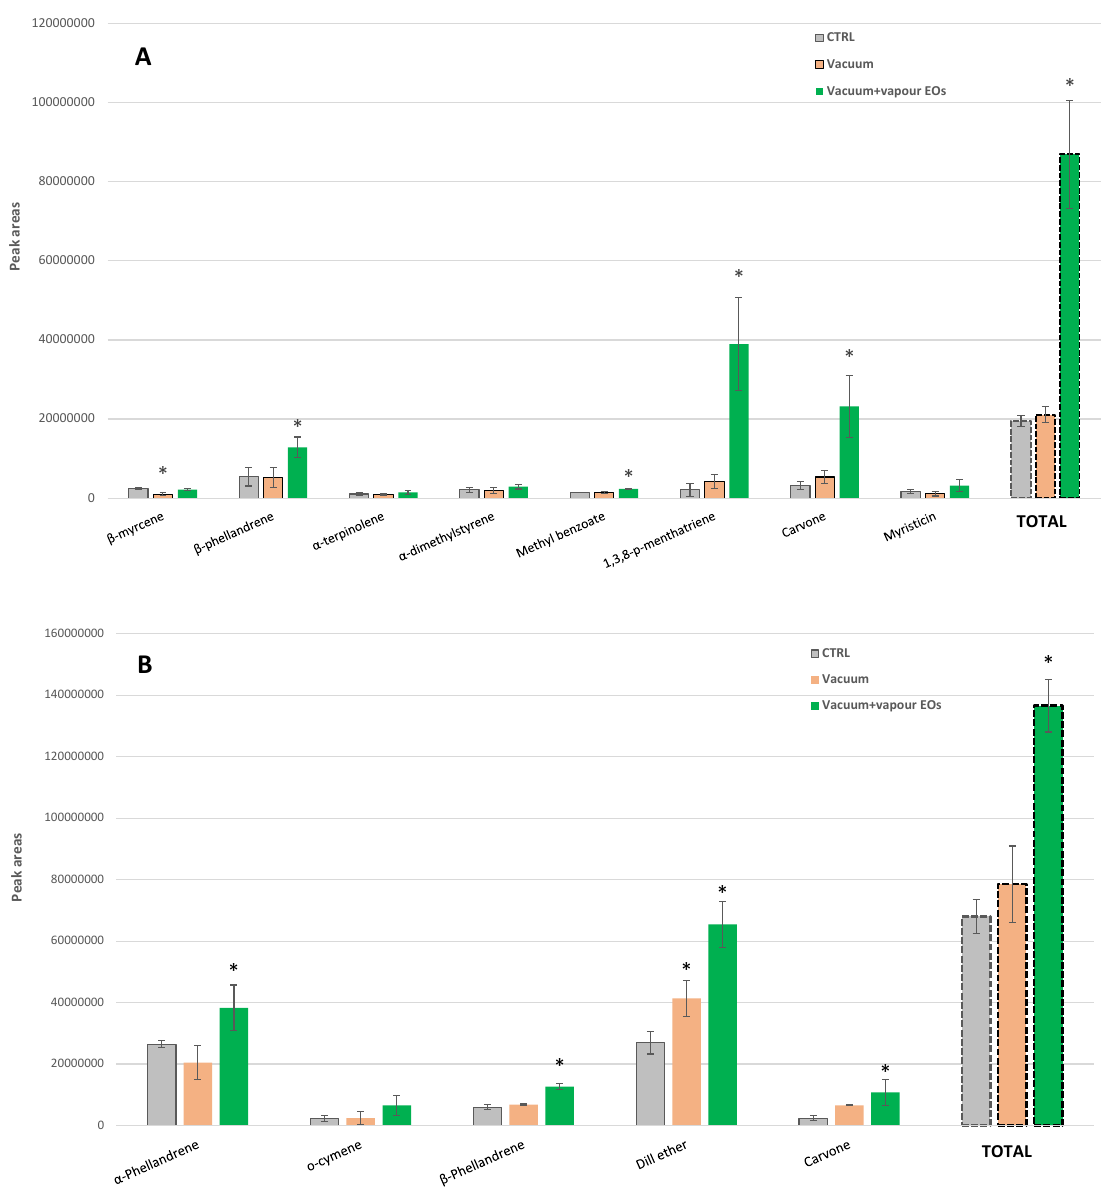
Figure 8. Volatile organic compounds profile of ( A ) curly parsley and ( B ) dill, untreated (CTRL) and treated with vacuum cooling, with and without application of vapor essential oils (EOs), at pilot plant scale (mean ± SD). * Significant differences ( p < 0.05) in treated samples (either vacuum or vacuum and EOs) compared to CTRL are designated with asterisks.